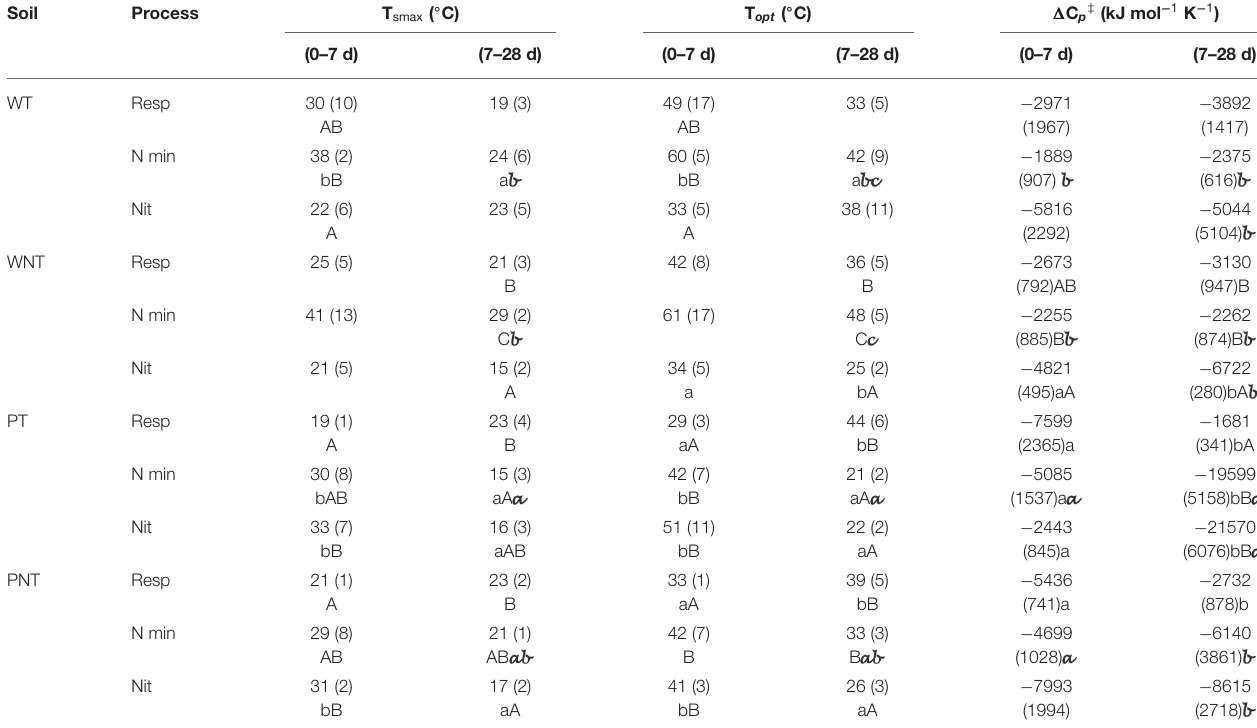
Values are the average of three field replicates with standard deviation in parentheses. Lower case letters indicate a significant difference in parameters between time intervals, and upper case letters indicate a significant difference in parameter values between processes within an individual soil (p ≤ 0.05). Significant differences in the thermodynamic response across sampling sites are indicated by bold lower case script (p ≤